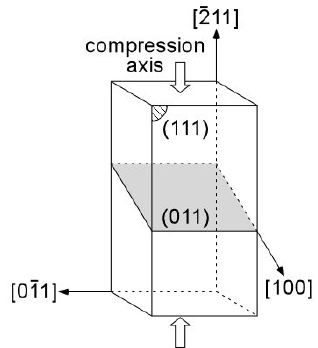
Figure 1. Schematic illustration of the sample for plastic deformations.